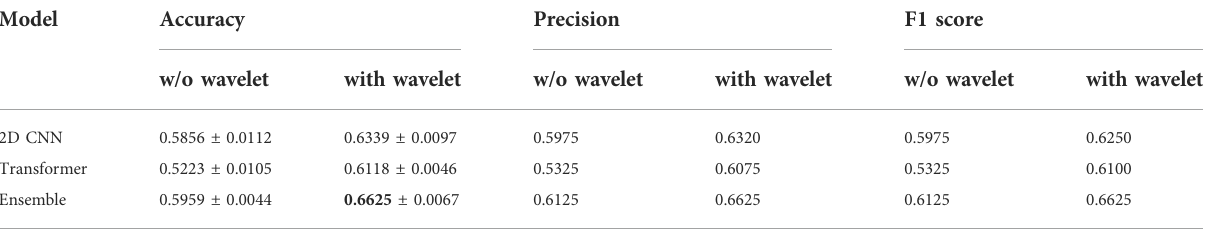
TABLE3Performanceofthetwomodelsandtheirensembleonthelevelsofhapticdelaydataset(fourclasses).The reported fi guresarethemeanand standard deviation for 5-fold cross validation obtained on the test set.